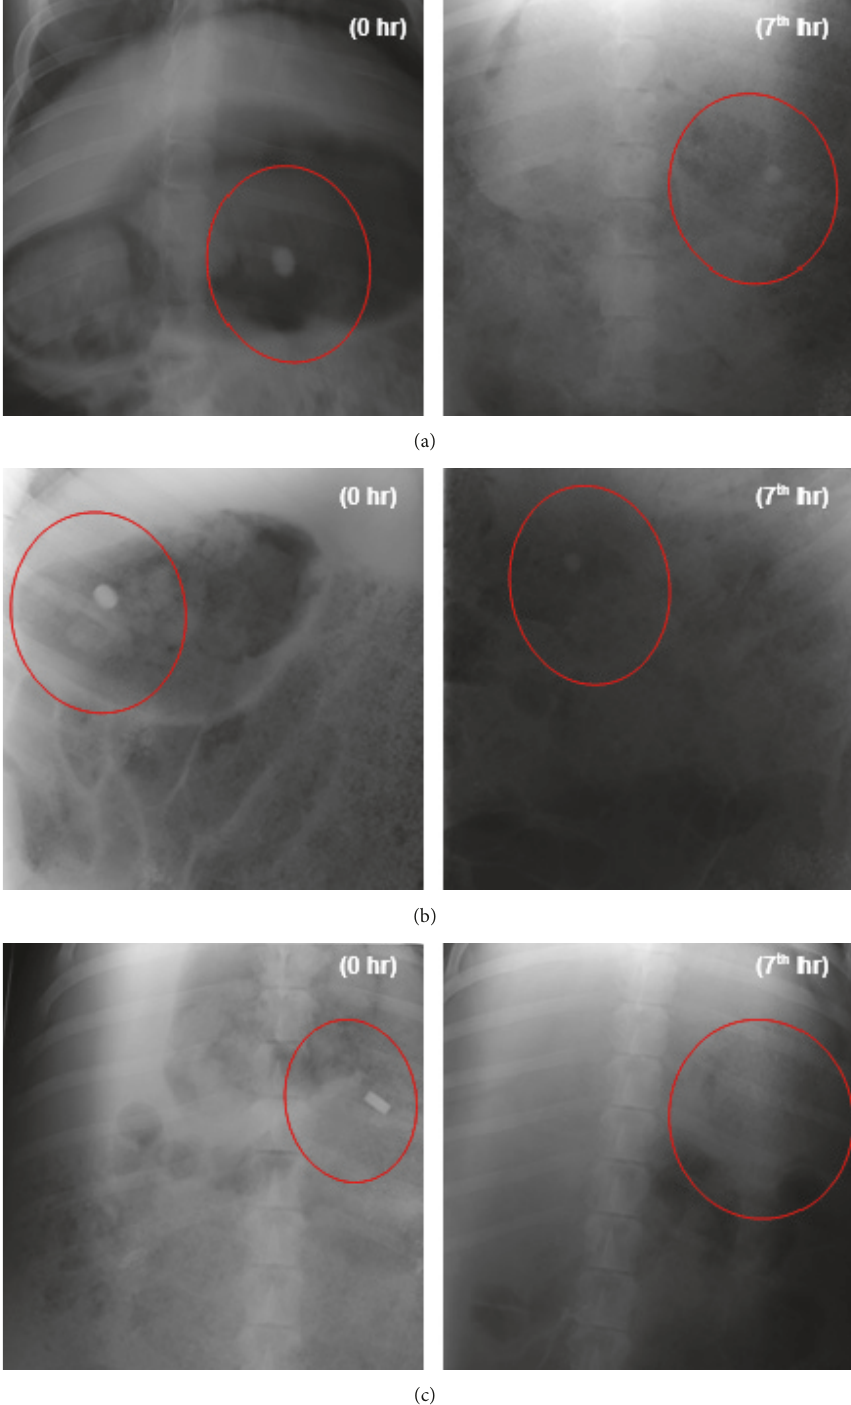
Figure 3: Radiographic images of (a) GDDS with the pig in the anterior-posterior position; (b) GDDS with the pig in the lateral position; and (c) PXLNET with the pig in the anterior-posterior